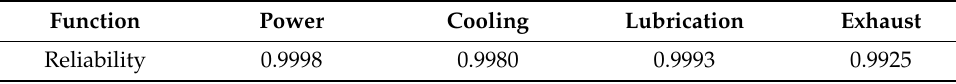
Table 3. Functional reliability distribution of the diesel engine. Function Power Cooling Lubrication